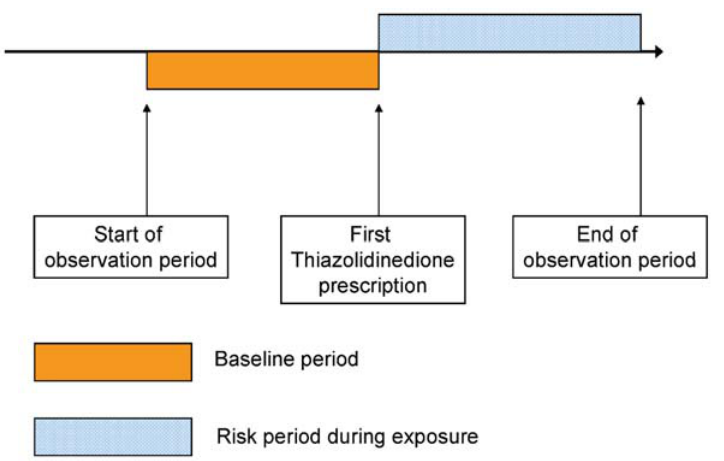
Figure 1. Representation of study design. The figure illustrates a single individual prescribed a thiazolidinedione during their observation period. All participants included in the analysis had at least one prescription for a thiazolidinedione and at least one fracture. The rate ratios presented are pooled estimates derived from the rate of events during the risk (exposed) periods divided by the rate of events during the baseline periods. Age is adjusted for at all stages of the analysis.